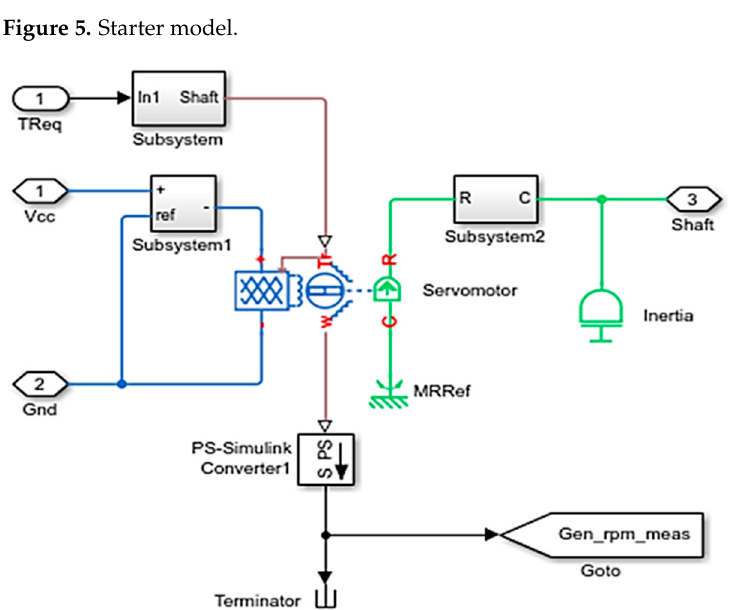
Figure 6. Generator model .